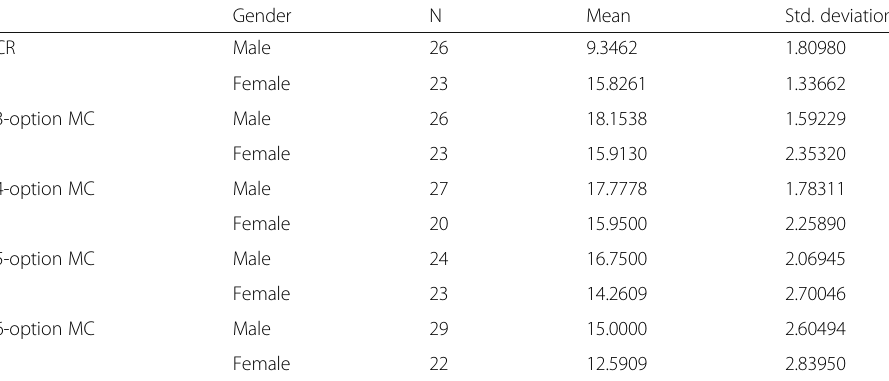
Table 5 Descriptive statistics for gender in CR, 3-, 4-, 5-, and 6-option MC vocabulary test Gender N Mean Std. deviation